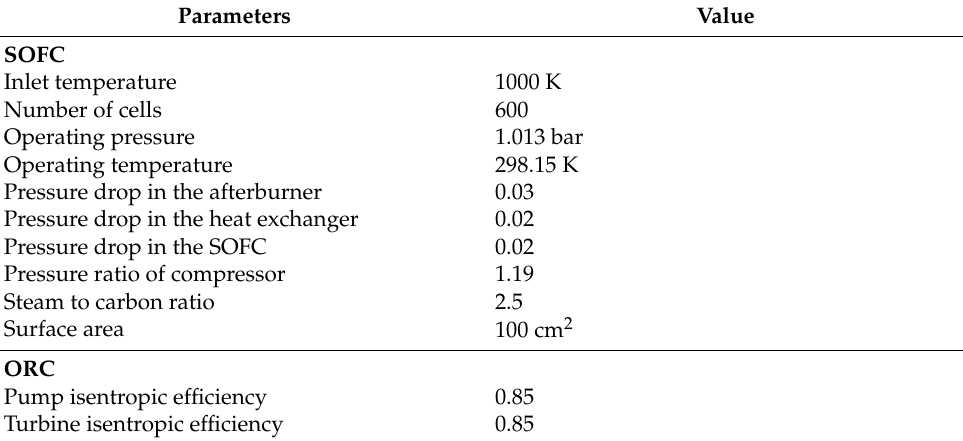
Table 2. Input operating parameters to perform the energy and exergy